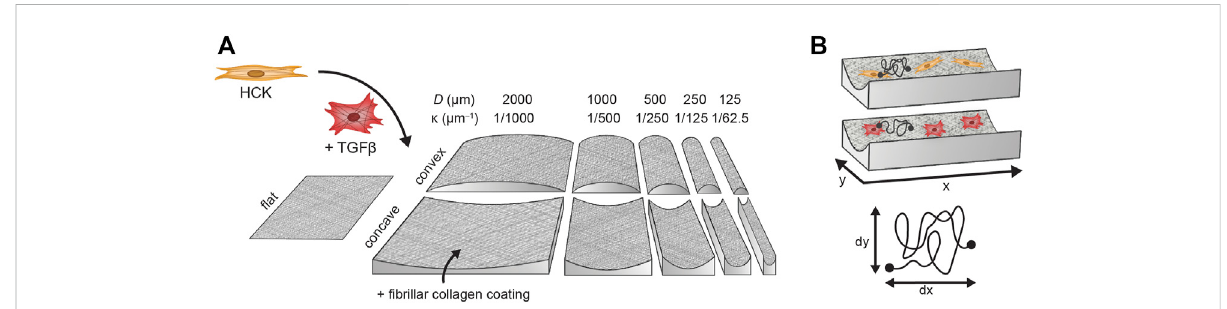
FIGURE 2 Experimental work fl ow of fi broblast (HCK) and myo fi broblast (HCK + TGF β ) migration on fl at substrates and semi-cylinders with diameters between 2000 µm ( κ = 1/1000 μ m − 1 ) and 125 µm ( κ = 1/62.5 µm − 1 ). (A) Cell adhesion and morphology of both cell phenotypes are captured on convex and concave cylinders. (B) Migration behavior is captured over time and quanti fi ed on concave